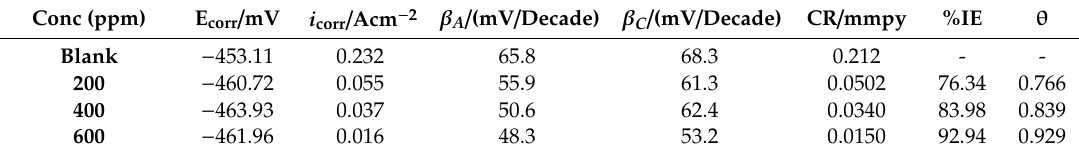
Table 1. Potentiodynamic polarization parameters of mild steel in 1 M HCl in the presence and absence of